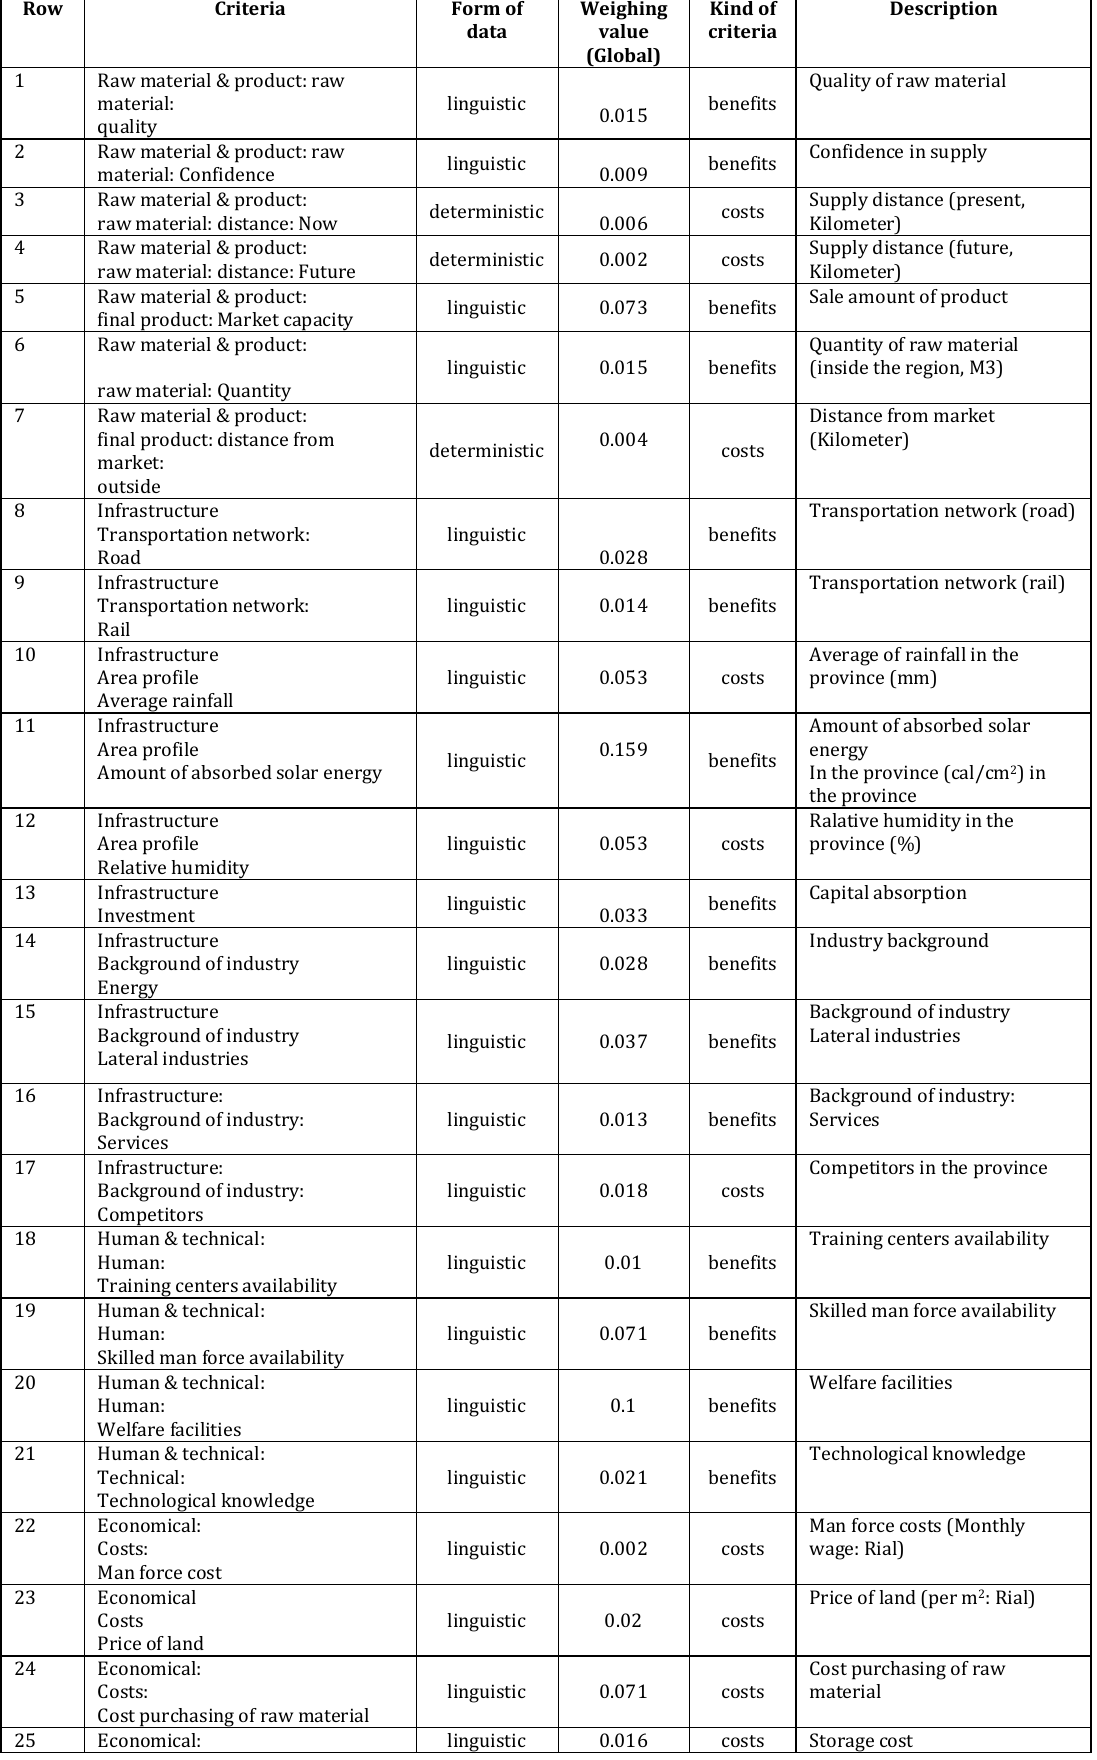
Table 1: Factor table, criteria and sub criteria of solar wood drying location selection and their weighing